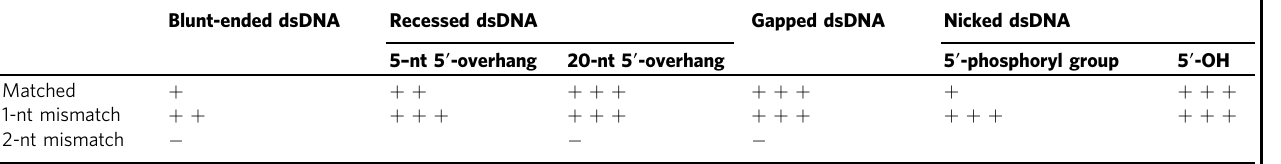
ThefouractivitylevelsforAPE1ondigestingDNAsubstratesarerepresentedby( − ),( + ),( ++ ),and( +++ ).( − ):cleavagepatterncannotbeobserved.( + ),( ++ ),and( +++ ):thecleavagepattern can be observed at the mAPE1 concentration of 0.75, 0.5, and 0.25 μ M, respectively. Space means the condition was not